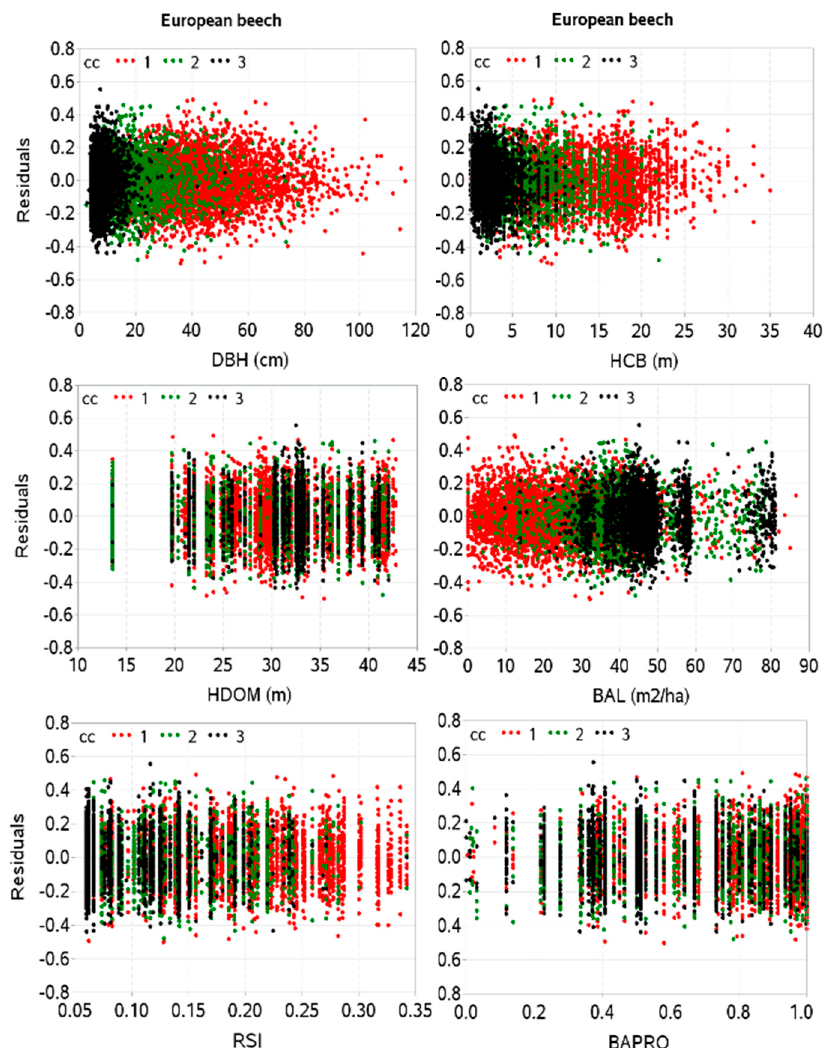
Figure 4. Standardized residuals plotted against various predictors in the CR model. Residuals versus diameter at breast height (DBH) and height to live crown base (HCB) (first panel), Residuals versus dominant height (HDOM) and basal area of larger trees in diameter than a subject tree (BAL) (second panel), Residuals versus relative spacing index (RSI) and basal area proportion of a species (BAPRO) (third panel). CC = canopy height class 1: height greater than 66% of the tallest tree, 2: height between 33% and 66% of the tallest tree, and 3: height less than 33% of the tallest tree.